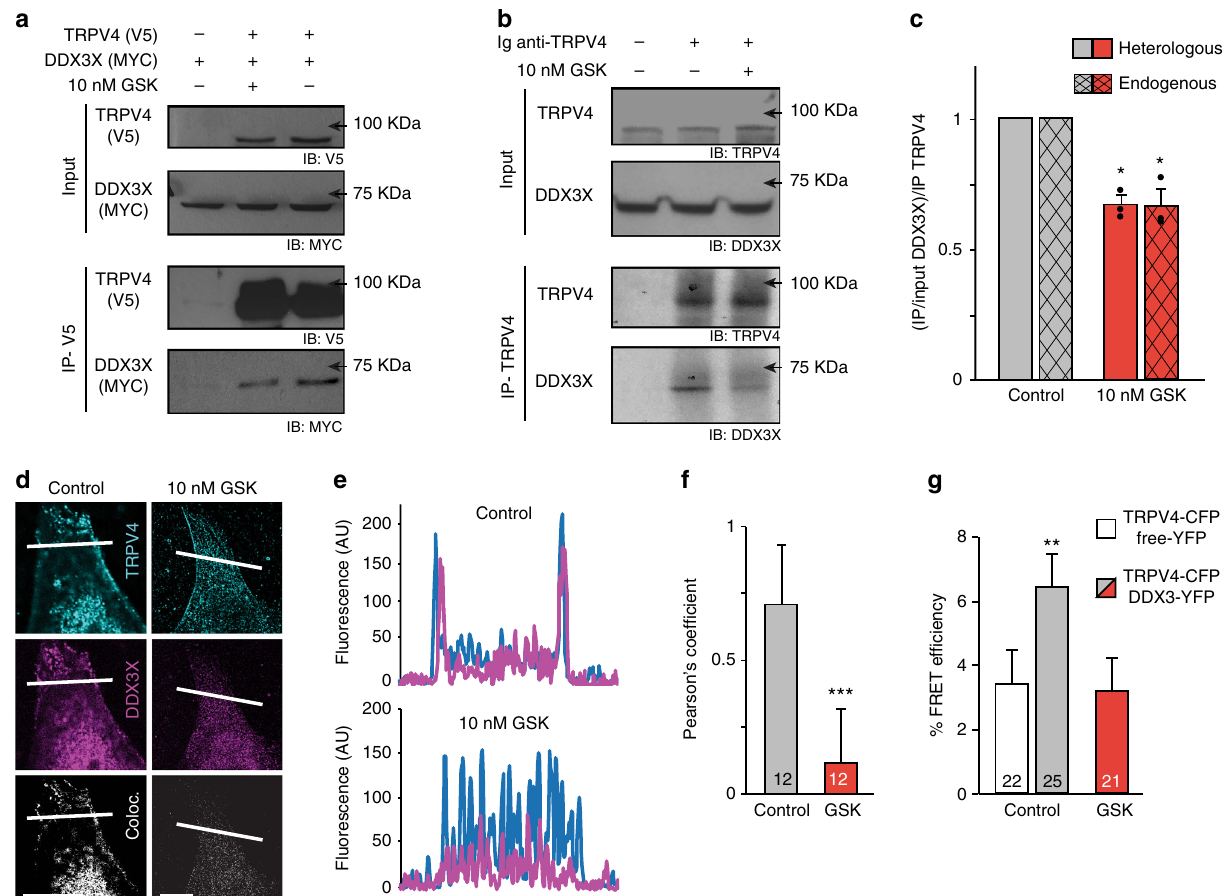
Fig. 1 TRPV4 interacts with DDX3X. a Co-immunoprecipitation (Co-IP) of TRPV4-V5(tag) and DDX3X-Myc(tag) in HEK293 cells. b Co-IP of